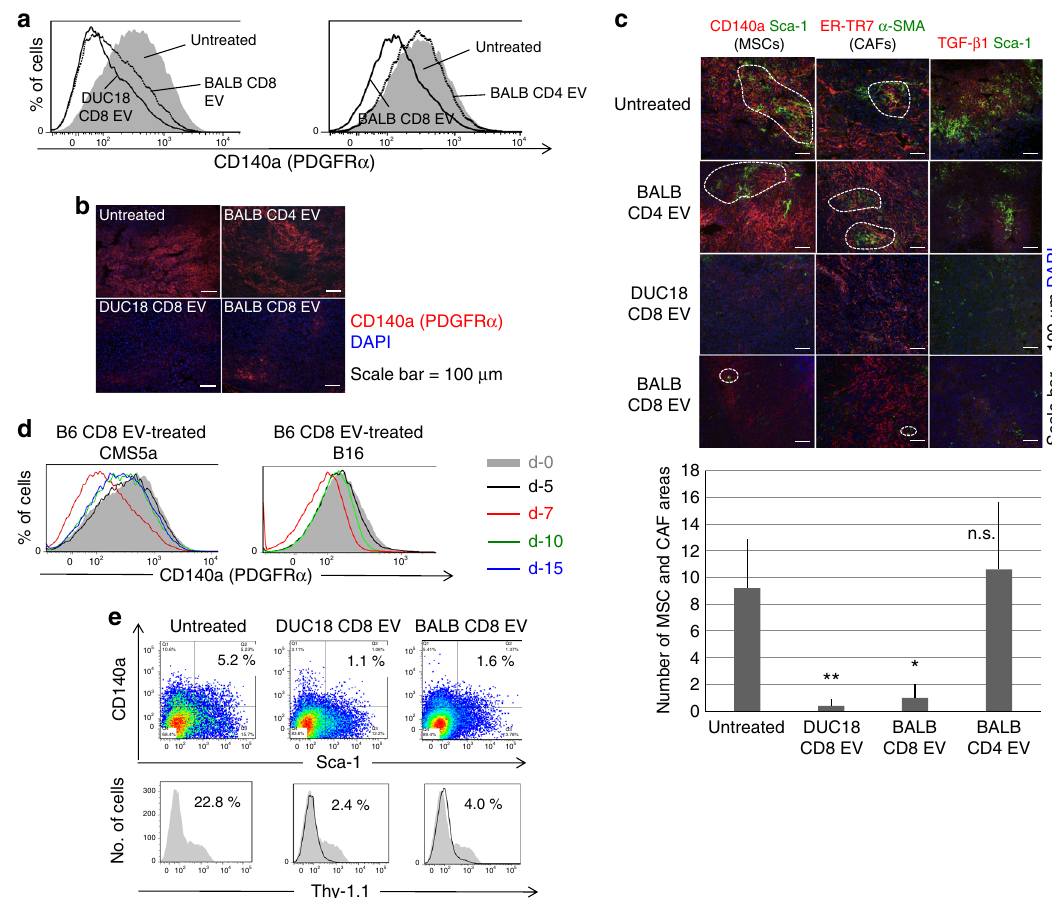
Fig. 1 Depletion of tumour mesenchymal stroma by i.t. treatment with CD8 + T cell EVs. Expressions of CD140a in a CMS5a tumour ( n = 4 per group) treated intratumorally with/without BALB CD8 EVs, DUC18 CD8 EVs or BALB CD4 EVs (10 μ g [5 – 7 × 10 8 vesicles]/tumour) are shown as histogram data obtained by fl ow cytometry ( a ) and representative photos of fl uorescent immunohistochemistry ( b ). Each photo is a representative of 4 – 5 photos. c CMS5a tumour on day 3 after treatment with the indicated EVs (10 μ g [5 – 7 × 10 8 vesicles]/tumour) were sectioned and dual stained with CD140a- and Sca-1-speci fi c mAbs, ER-TR7- and α -smooth muscle actin-speci fi c mAbs, or TGF- β - and Sca-1-speci fi c mAbs. Each photo is a representative of 5 – 6 photos. The dotted circles express the overlapping areas of PE and FITC fl uorescence. The number of overlapping areas of DUC18 CD8 EVs (**) and BALB CD8 EVs (*)-treated groups were signi fi cantly different from the untreated group with p < 0.01 and p < 0.05, respectively (n.s., not signi fi cant; error bars indicate SEM). The data were analysed by a two-tailed unpaired Student t -test. d EVs (10 μ g [5 – 7 × 10 8 vesicles]/tumour) prepared from day 5, 7, 10 or 15 culture medium of both TRP-2 peptide and gd100 peptide-stimulated B6 splenocytes were injected into subcutaneous CMS5a or B16 tumours. Three days after EV treatment, the CD140a expression in tumour cell suspensions was examined by fl ow cytometric analysis. e CMS5a cells were inoculated subcutaneously into Thy-1.1 + bone-derived MSC-chimeric BALB/c mice ( n = 4 mouse per group). DUC18 CD8 EVs or BALB CD8 EVs (10 μ g [5 – 7 × 10 8 vesicles]/tumour) were injected into day 12 subcutaneous CMS5a tumours. 3 days after EV treatment, the % of CD140a + and Sca-1 + cells and transferred Thy 1.1 + cells